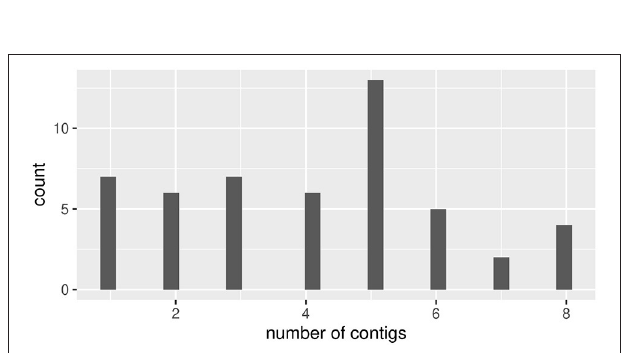
FIGURE 8 | The number of short contigs generated by Unicycler for random read data generated from MF925724 reference.